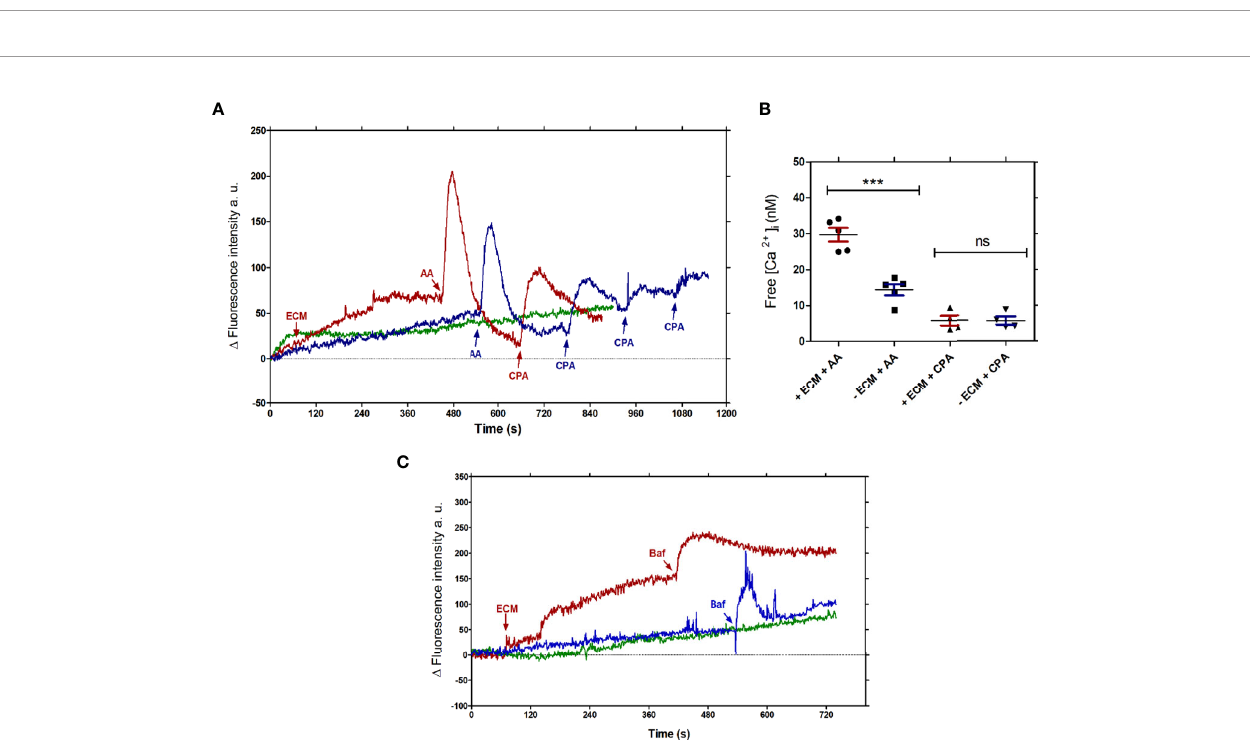
FIGURE 4 | Organelles involved in the Ca 2+ homeostasis in T. cruzi trypomastigotes upon interaction with the ECM. (A) Measurement of the intracellular free Ca 2+ concentration in the presence of AA (0.3 µg/mL) or CPA (0.3 µM); Trypomastigotes + ECM (MTy, red line); Trypomastigotes (Ty, Blue line); basal signal from non- stimulated 5 x 10 7 parasites (Green line). (B) Free calcium concentration measured in MTy incubated in the presence or absence of AA and CPA. The graphs are representative of fi ve independent experiments, as shown in Figure 4A . The size of the peaks was estimated from the addition point to the maximum top. Statistical signi fi cance (One-way ANOVA) p < 0.01. (C) Measurement of the intracellular Ca 2+ concentration of trypomastigotes in the presence or absence of Baf (1 µM); MTy (Red line); Ty (Blue line); basal signal from parasites not stimulated (Green line). The graph is representative of three independent experiments. MTy: 5 x 10 7 trypomastigotes + 24 µg of ECM. ***P < 0.001; ns, no signi fi